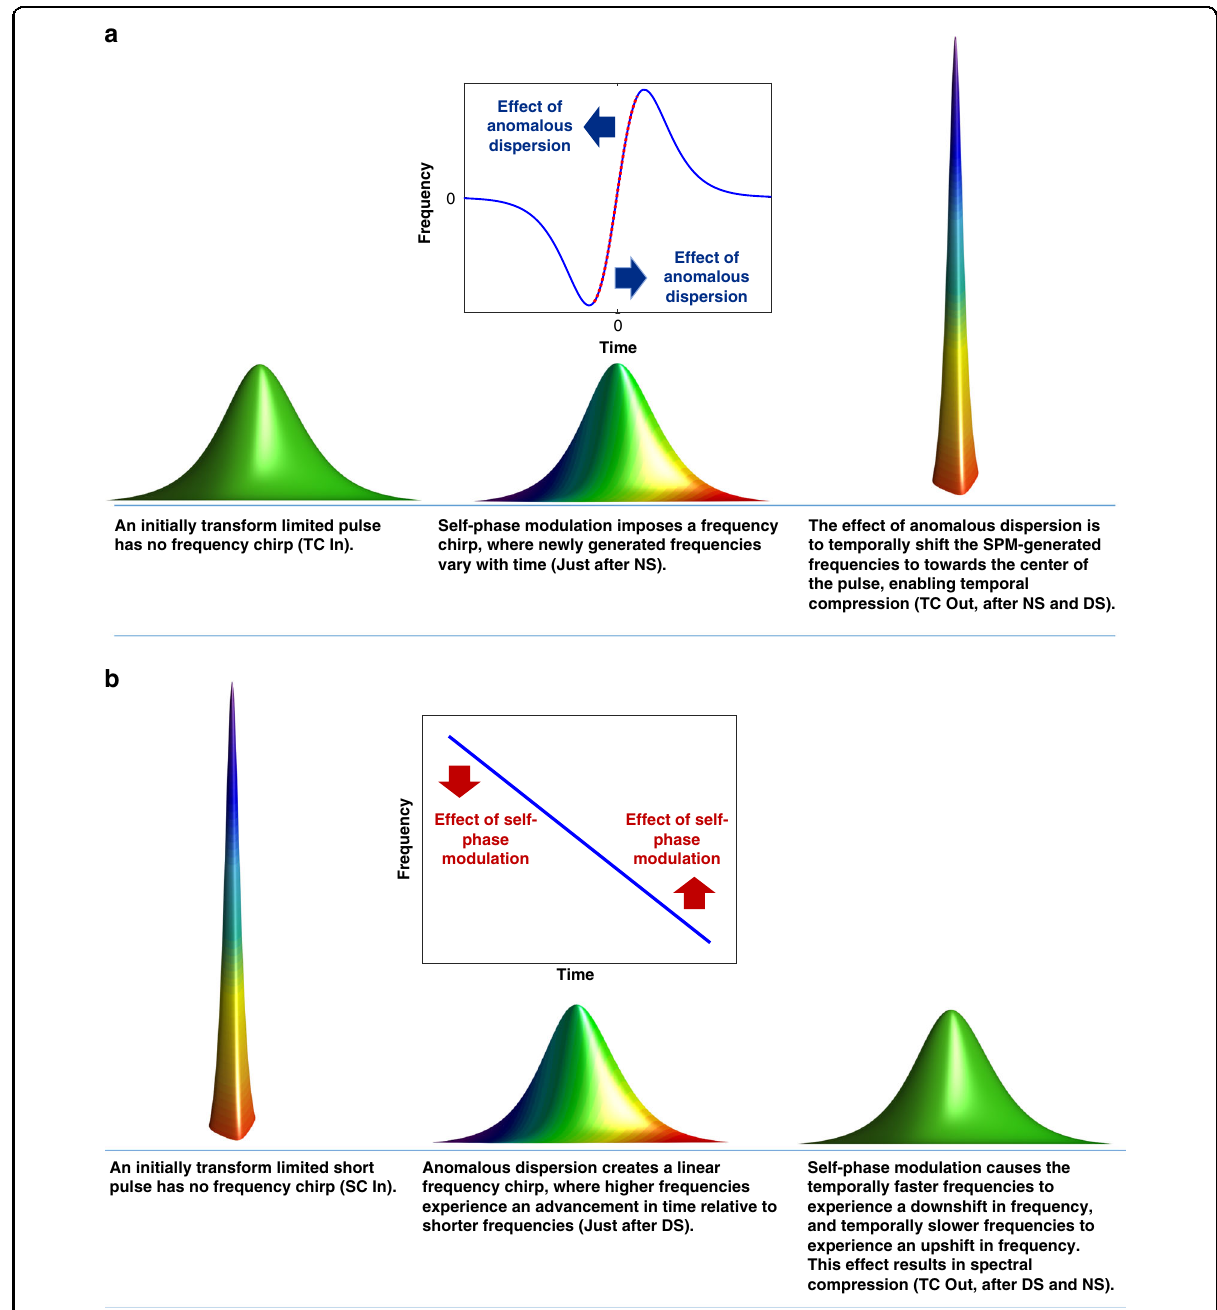
Fig. 2 Principles of the nonlinear USRN pulse compressor. a Compression in the temporal domain involves the acquisition of new frequencies via SPM. In the second stage, anomalous dispersion temporally shifts the generated frequencies toward the center of the pulse, in so forth achieving temporal compression. b Compression in the spectral domain involves fi rst applying anomalous dispersion to the pulse. This imparts a chirp to existing pulse frequencies. SPM comes in at the second stage and creates a frequency downshift in the temporally faster frequencies, and a frequency upshift in the temporally slower frequencies. Brackets in captions denote the location of the pulse with reference to Fig.